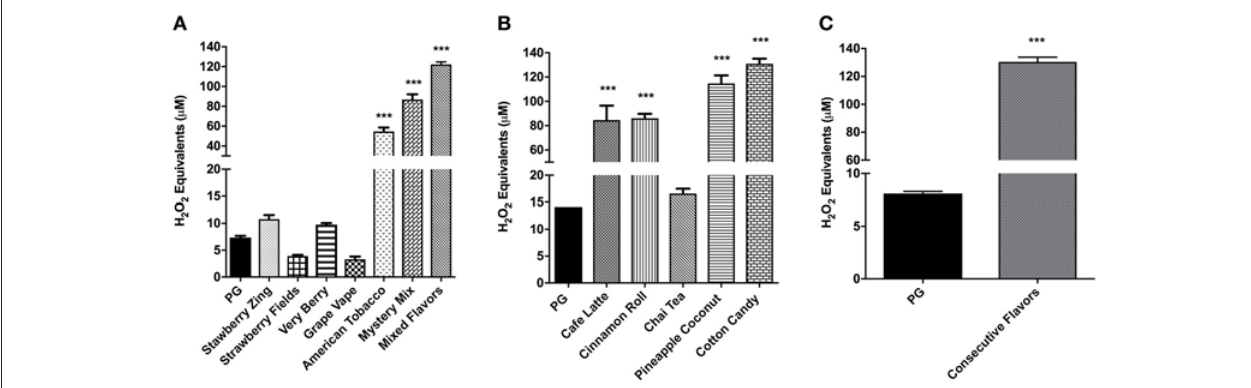
FIGURE 5 | (A) Cell-free ROS in flavored e-liquids with a new atomizer at each use with one puff per min. E-liquids (Strawberry Zing, Strawberry Fields, Very Berry, Grape Vape, American Tobacco, Mystery Mix and Mixed Flavors) aerosols were drawn through the DCFH solution using a SciReq inExpose. Oxidized DCF fluorescence was measured using a fluorometer. Data are shown as mean ± SEM ( n = 6 per group). Statistical significance was determined by One-way ANOVA (Tukey’s multiple comparison test). *** P < 0.001 vs. propylene glycol. (B) Cell-free ROS in selected e-liquids using a PG aerosolized atomizer. Selected e-liquid aerosols (Café Latte, Cinnamon Roll, Chai Tea, Pineapple Coconut and Cotton Candy) were aerosolized using a SciReq inExpose and drawn through DCFH with PG aerosolization in between e-liquids. Oxidized DCF fluorescence was measured using a fluorometer. Data are shown as mean ± SEM ( n = 2–6 per group). Statistical significance was determined by One-way ANOVA (Tukey’s multiple comparison test). *** p < 0.0001 vs. propylene glycol. (C) Cell-free ROS in acute exposure of consecutively aerosolized flavors. Ten e-liquid flavors (Strawberry Zing, Café Latte, Pineapple Coconut, Cinnamon Roll, Fruit Swirl, Mega Melons, Mystery Mix, American Tobacco, Grape Vape and Very Berry) were aerosolized consecutively (consecutive mixture of flavors) using a SciReq inExpose machine one flavor at a time during a cumulative 10min period and drawn through DCFH. Oxidized DCF fluorescence was measured using a fluorometer. Data are shown as mean ± SEM ( n = 6). Statistical significance was determined by student t -test. *** p < 0.001 vs. PG.